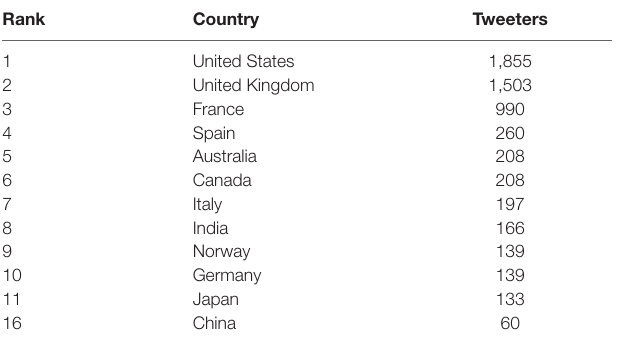
Table 6 | countries ranked by number of articles tweeted by more than 100 tweeters. rank